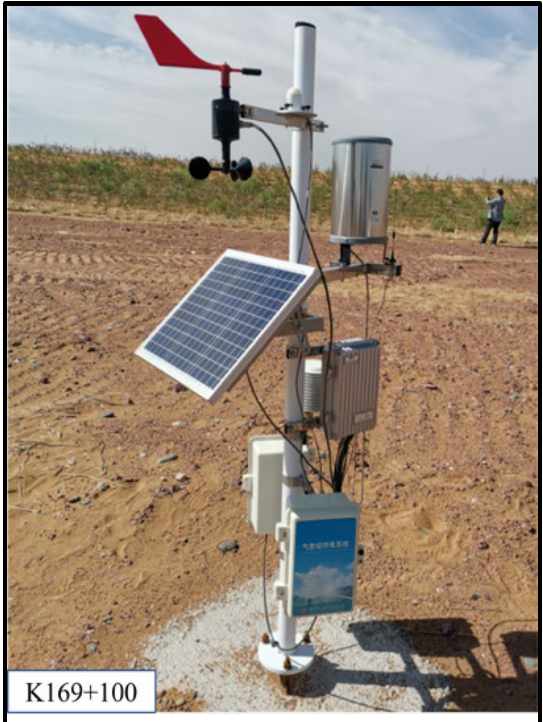
Figure 2. Remote Weather Monitoring Station.